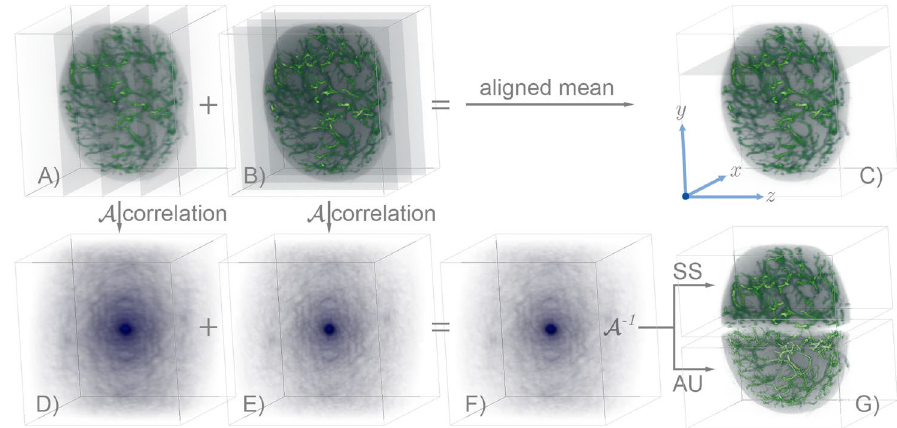
Figure 1. Reconstruction pipeline. ( A ) Rendering of the reference view taken at ϕ = 0 ◦ . The planes indicate the xy -camera acquisition along the z -scanning direction. ( B ) Orthogonal detection by rotating the sample at ϕ = 90 ◦ . ( C ) Aligned-average of 12 measurements. The axes are chosen according to the reference view ( x -lateral, y -transverse, z -longitudinal). ( D ) Auto-correlation of the view at 0 ◦ . ( E ) A of the view at 90 ◦ . ( F ) A averaged through 12 angles. ( G ) Reconstructions obtained by using deauto-correlation methods. For visual comparison, the upper part shows the result using the Schultz-Snyder protocol. The bottom one compares it with that of the Anchor-Update